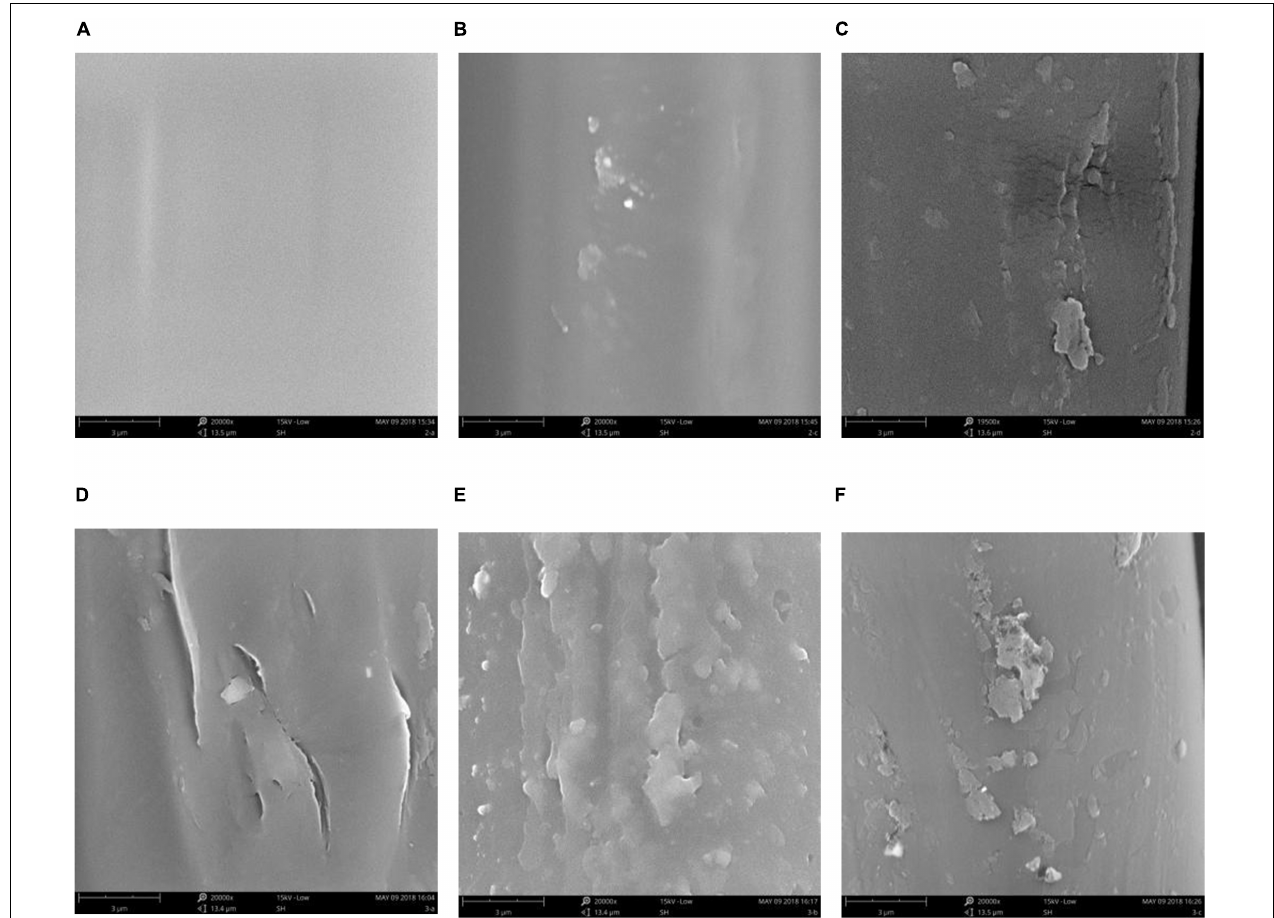
FIGURE 2 | Surface SEM images of different DA-concentration-modified PET ligament. (A) 0 mg, (B) 5 mg, (C) 10 mg, (D) 20 mg, (E) 50 mg, and (F) 100 mg.